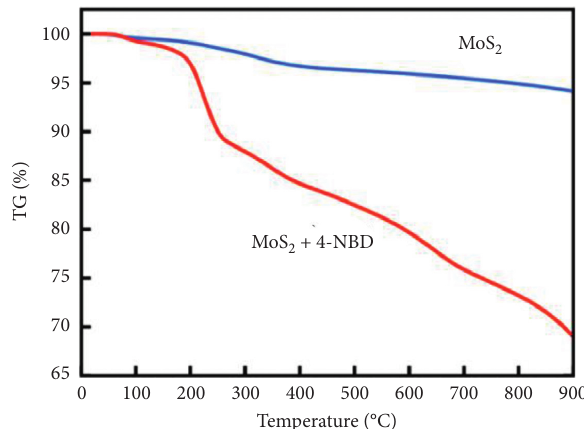
Figure 21: TGA thermogram of pure MoS functionalised MoS 2